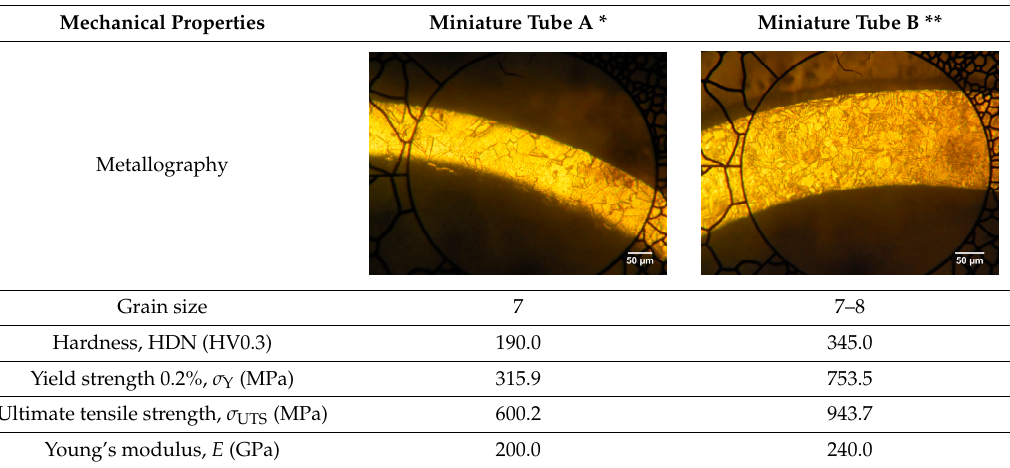
Table 4. Mechanical properties of miniature tube materials [24].